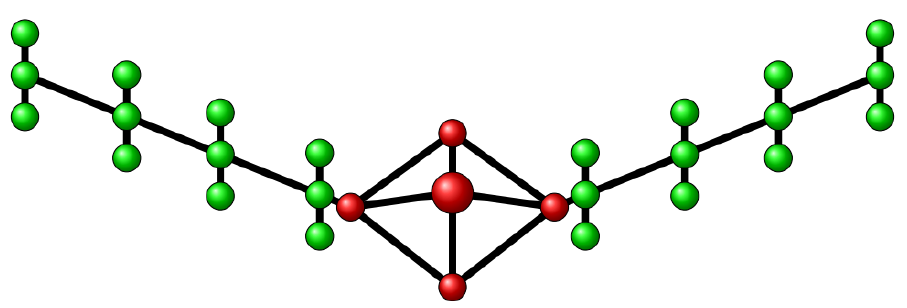
Figure 13. Spline grid on the Mini MUTT aircraft